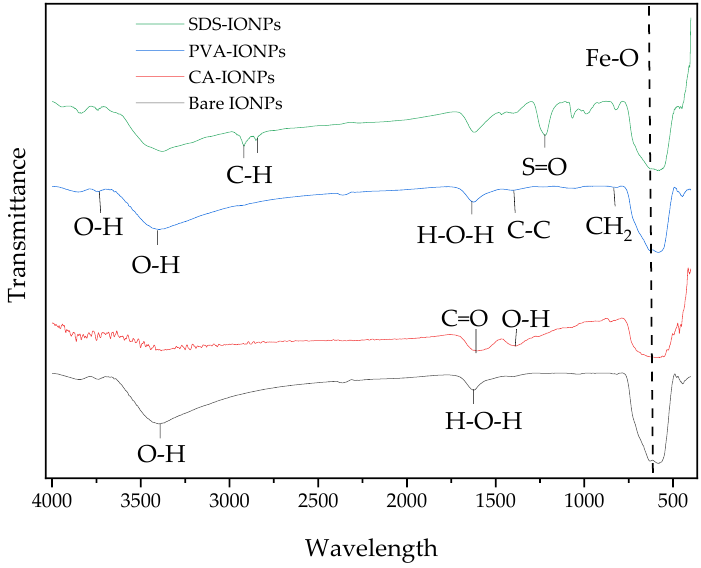
Figure 6. FTIR spectra of bare IONPs, CA-IONPs, PVA-IONPs, and SDS-IONPs.